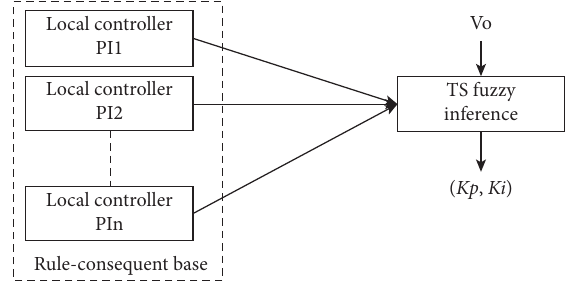
Figure 13: Structure of TS fuzzy controller.